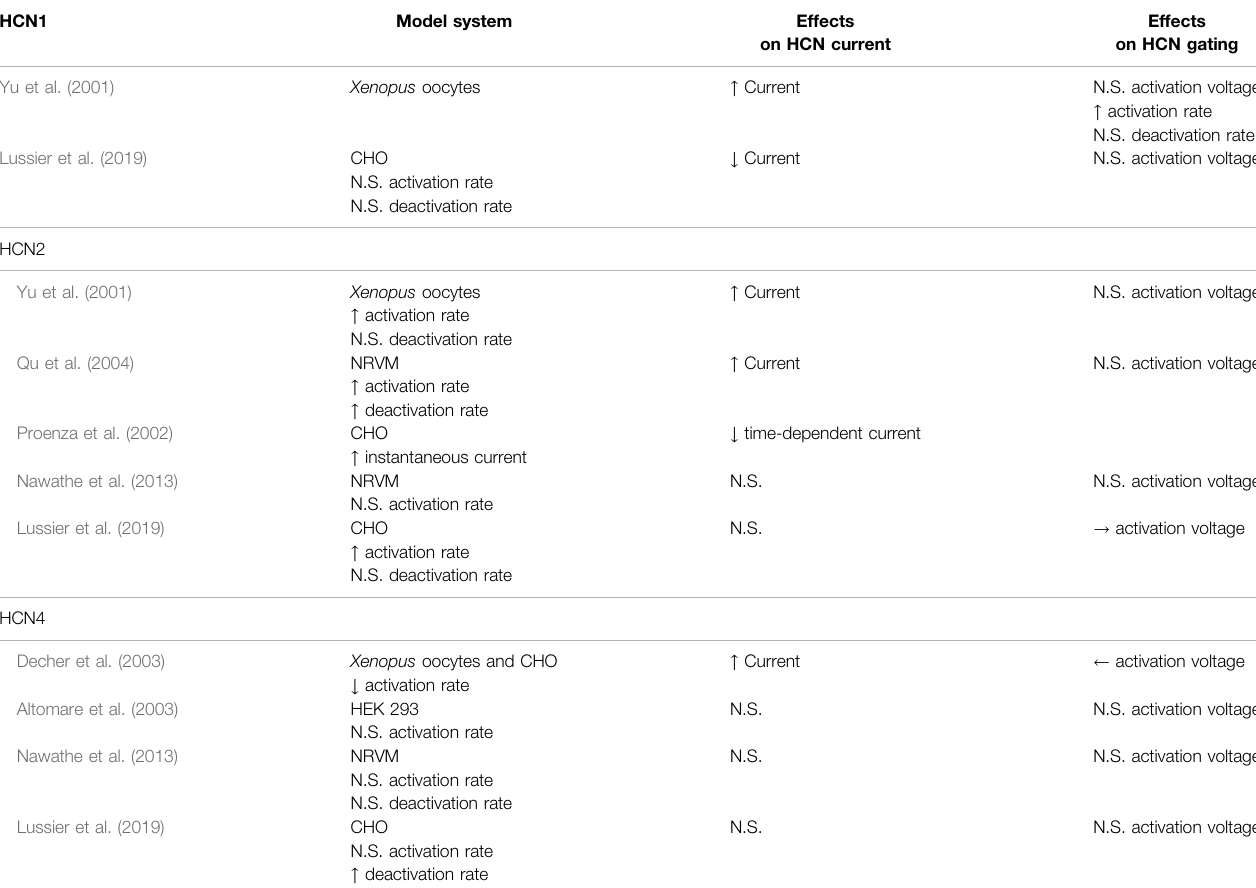
TABLE 1 | Effects of KCNE2 on HCN channel